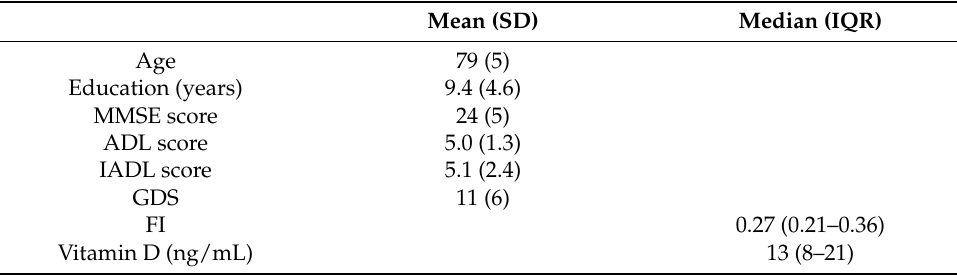
Table 2. Characteristics and vitamin D levels of the overall cohort.